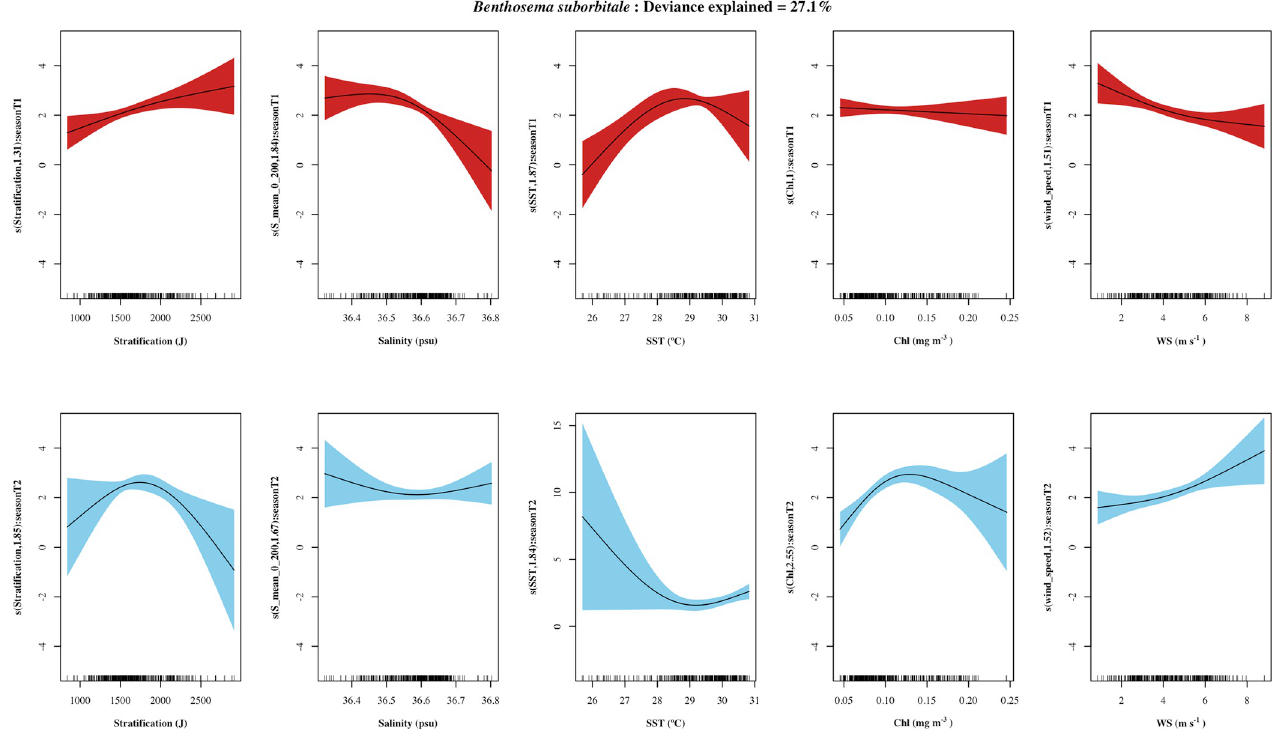
Fig 4. Response plots of the oceanographic variables’ additive effect on the density of Benthosema suborbitale . Season I (April-July) in red and season II (August-October) in blue. Smoothed values represented by a continuous line, and shaded color indicates 95% confidence intervals. Variables with non- significant additive effects (p > 0.05) for a given season are not